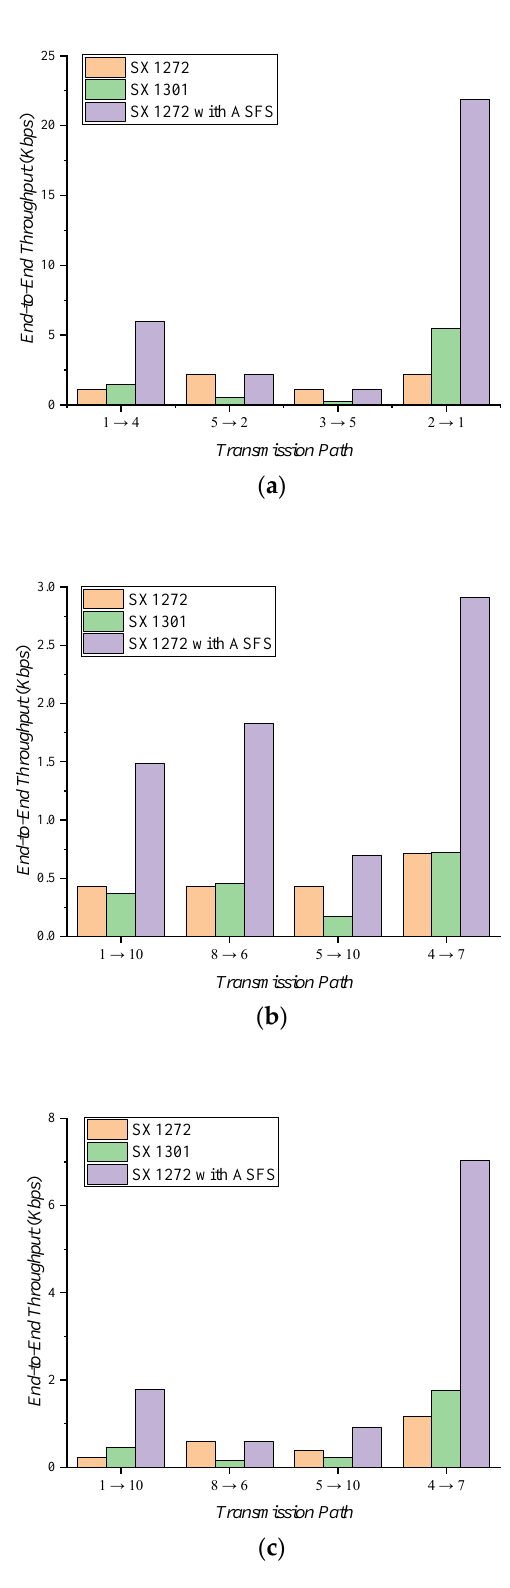
Figure 6. End-to-end throughput according to router type: ( a ) Star Topology; ( b ) Tree Topology; ( c ) Mesh Topology .